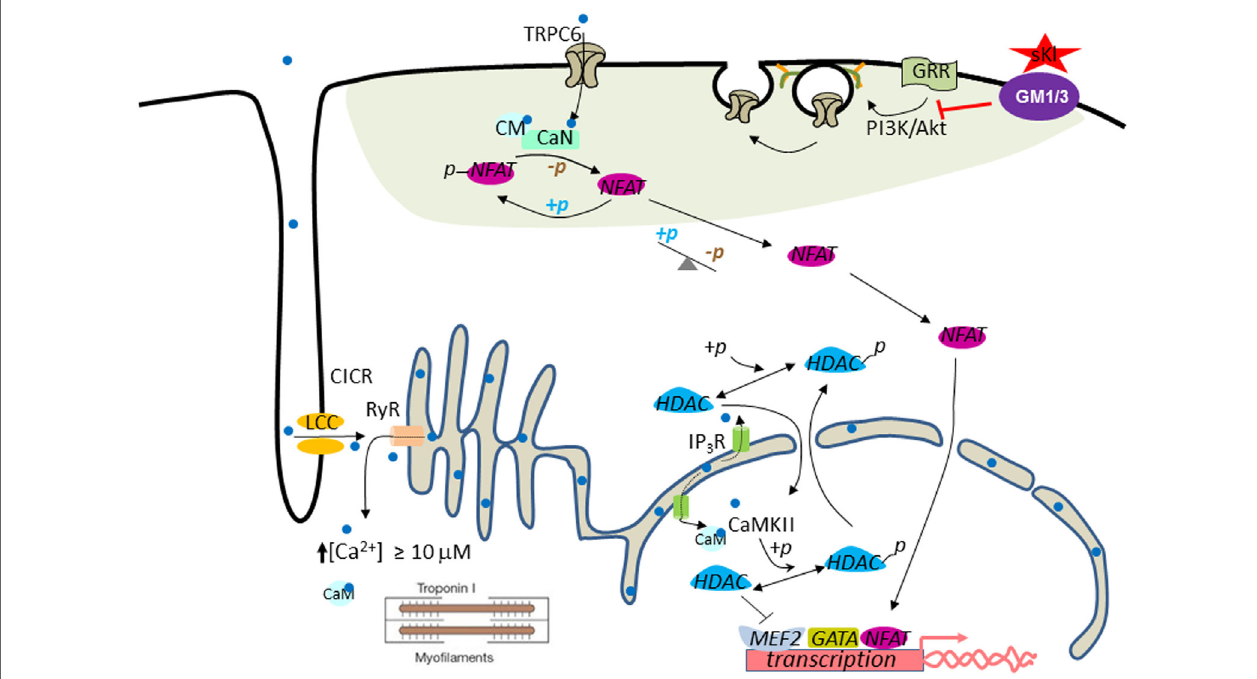
FiGURe 2 | Working model for cardioprotection by soluble klotho (sKl). In the systolic phase, Ca 2 + (light blue dot) enters through L-type Ca 2 + channels (LCC) in the T-tube and initiates Ca 2 + -induced Ca 2 + release (CICR) from ryanodine receptors (RyR). This process results in increased intracellular [Ca 2 + ] to ≥ 10 µM to trigger cardiac contraction (i.e., contractile Ca 2 + ). Pathological cardiac remodeling and hypertrophy are triggered by compartmentalized abnormally elevated Ca 2 + levels, called signaling Ca 2 + . Perinuclear/nuclear Ca 2 + released from inositol trisphosphate receptor (IP3R) present in the nuclear envelope activates CaMKII–HDAC–MEF2 nuclear signaling cascade. CaMKII, Ca 2 + /calmodulin-dependent protein kinase II; HDAC, histone deacetylase; MEF2, myocyte-enhancer factor-2. Activation of the TRPC6–CaN–NFAT signaling cascade originated from the sarcolemmal TRPC6 channels amplify and sustain cardiac hypertrophic gene expression through a feed-forward circuit [see text for details; calcineurin (CaN)]. Phosphoinositide 3-kinase (PI3K)–Akt signaling is important for exocytotic insertion of TRPC6-containing vesicles. sKl binds to gangliosides GM1 and GM3 (purple ovale) present in the membrane lipid rafts (green–gray shaded area) to inhibit raft-dependent PI3K signaling and TRPC6 channel function. Note that TRPC6 is localized to the lipid raft membrane